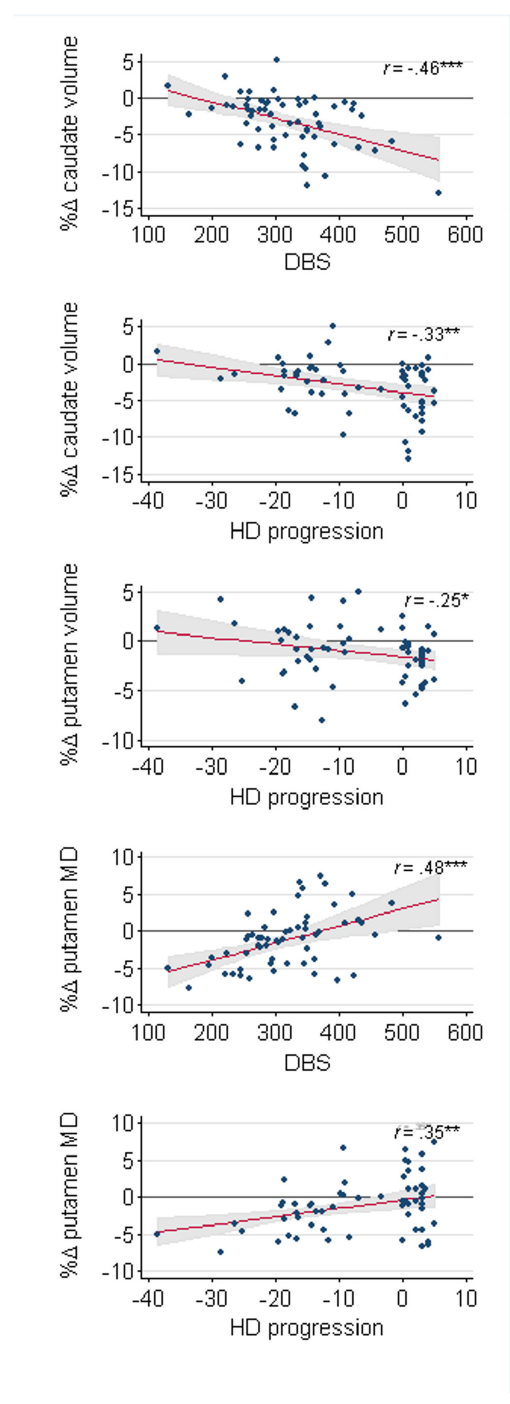
Figure 2. Significant correlations between percent change of baseline (%Δ) in caudate and putamen MR measures and clinical scores. Plots show fitted lines (and 95% CI, shaded area) adjusted for covariates. DBS: Disease Burden Score; HD progression is a composite of estimated years to clinical diagnosis (expressed in negative numbers as count to 0) and years since diagnosis (count from 0). doi: 10.1371/journal.pone.0074131.g002 PLOS ONE |